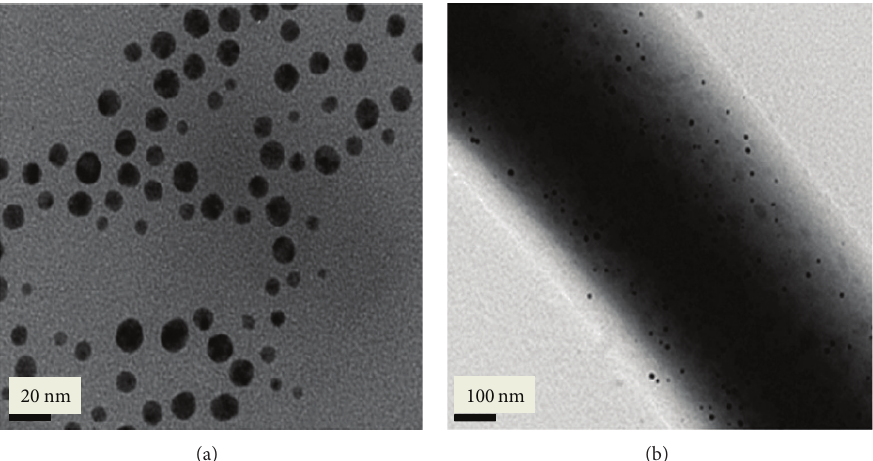
Figure 6: TEM images of (a) free silver nanoparticles and (b) silver nanoparticles distributed to the PHBV nanofibrous scaffolds (PHBV/Ag 1.0). Reproduce from Xing et al. with permission from ACS publishers